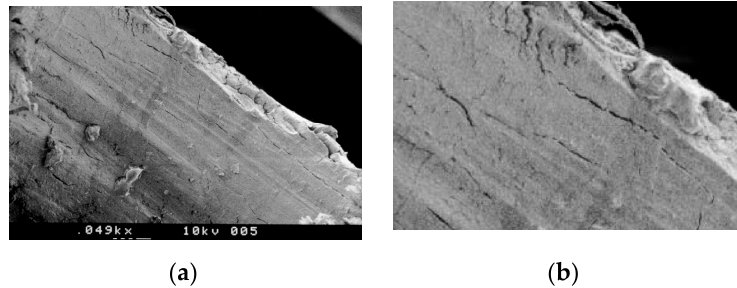
Figure 1. Scanning electron microscopy (SEM) analysis of a drill implant site preparation: ( a ) The attrite of the sharp tip of the drill on cortical bone formed an implant site signed by several turning strips. Compressed bone fragments formed a smear layer covering most of the bone vascular canals.